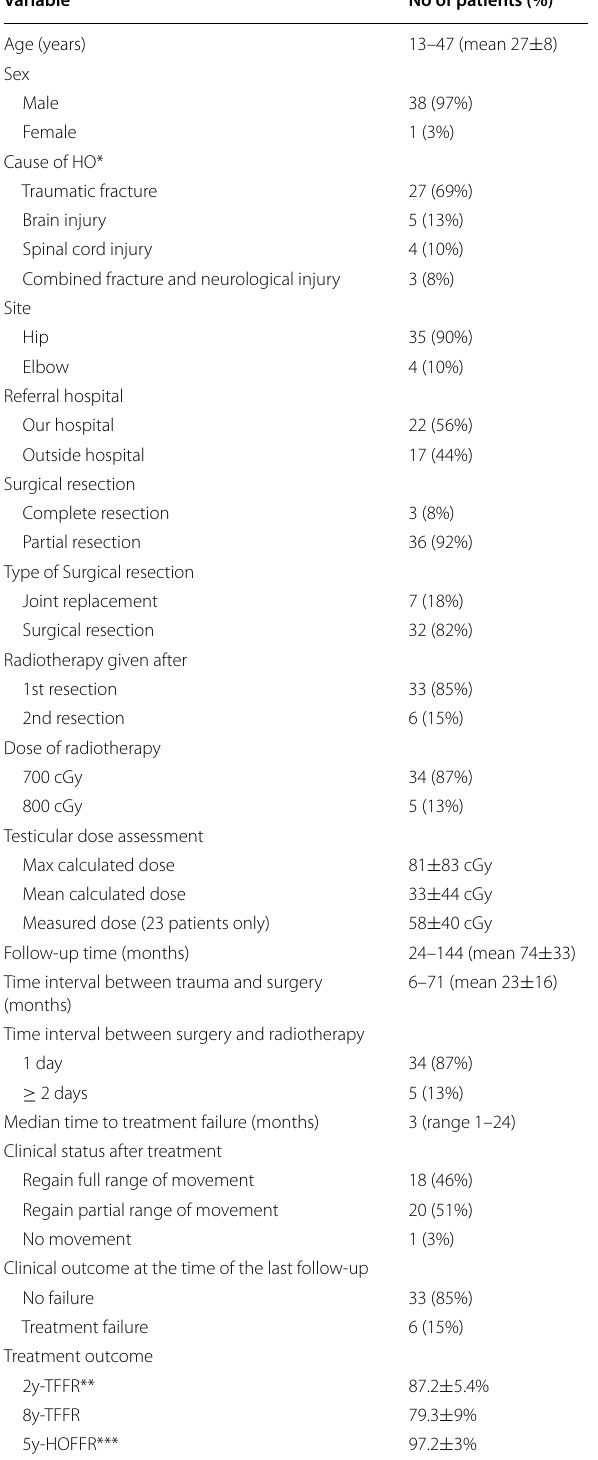
Table 2 Patients’ characteristics and treatment